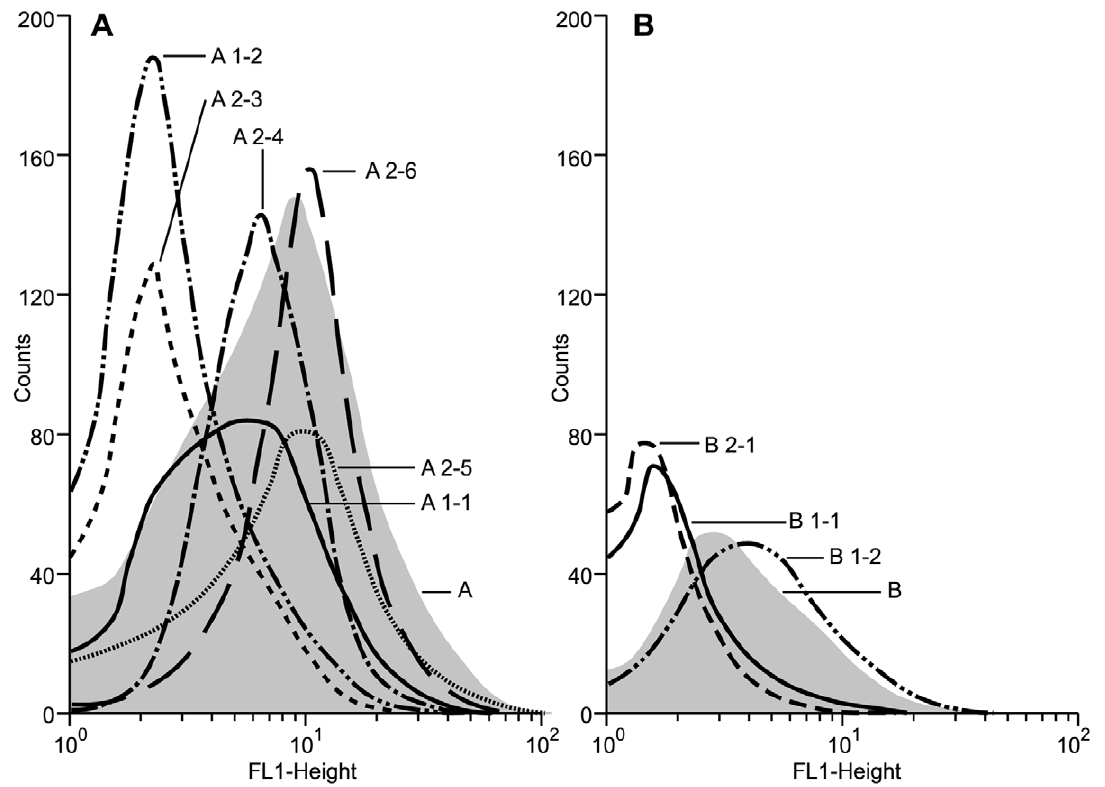
Figure 2. FACS analysis of EGFP expression in original and rederived cell lines. Green fluorescence generated by the transgenic bovine cells was determined using the FL1 emission channel. The relative numbers of viable cells was plotted as a function of variable intensities of green fluorescence from individual cells. (a) the original cell line A and all its rejuvenated derivatives and (b) cell line B and the cell lines that were rederived from